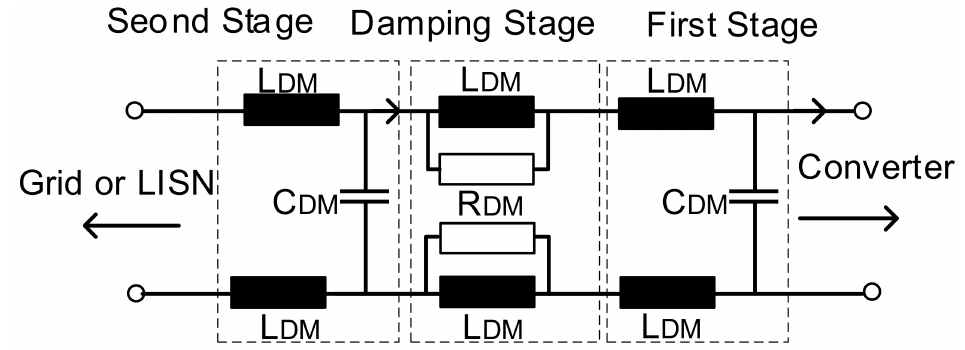
Figure 2. Symmetrical two-stage differential mode (DM) EMI filter